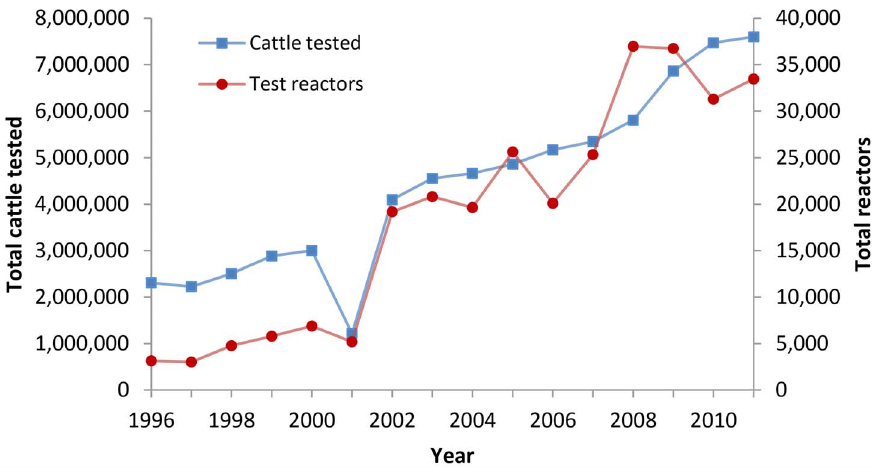
Figure 1. BTB testing in Great Britain, 1996–2011 [ 14 ] . The total number of cattle tested for the presence of an immune response to Mycobacterium bovis , and the total number of cattle testing positive in these tests, are shown.